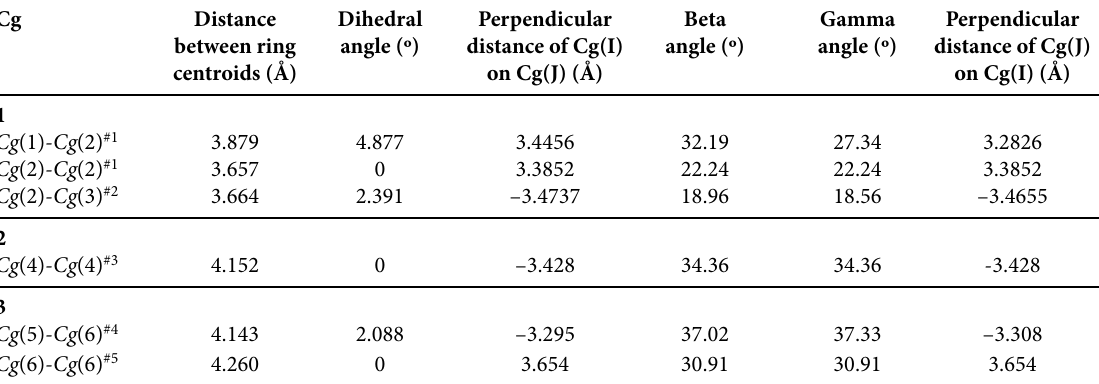
Table 3. Parameters between the planes for the complexes